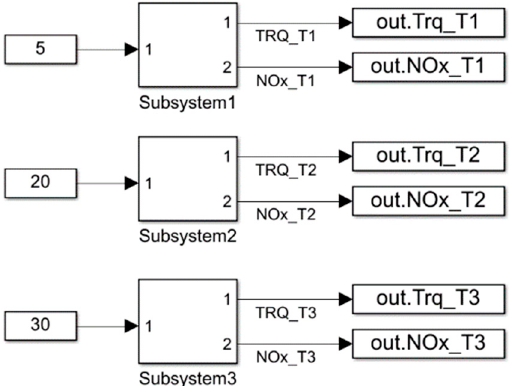
Figure 6. Analysis Model of Influence of Ambient Temperature on Engine Torque Performance.